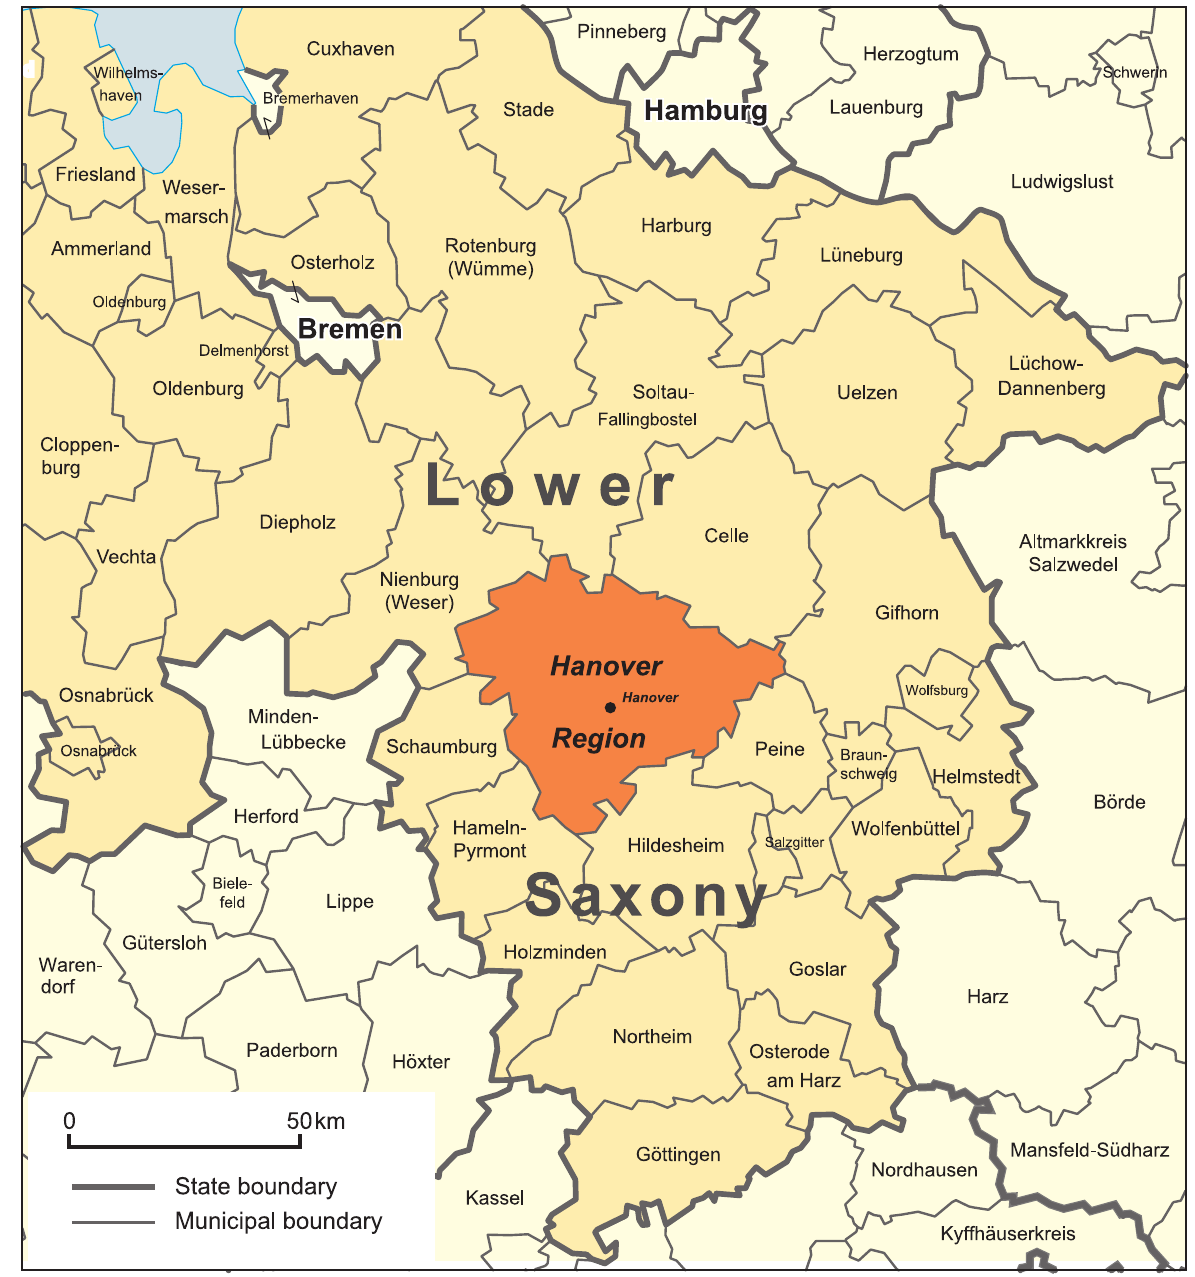
Fig. 1. Location of the Hanover region. Source: BBSr Bonn 2010, raumordnungsregionen 2009, cartographic elaboration by P.